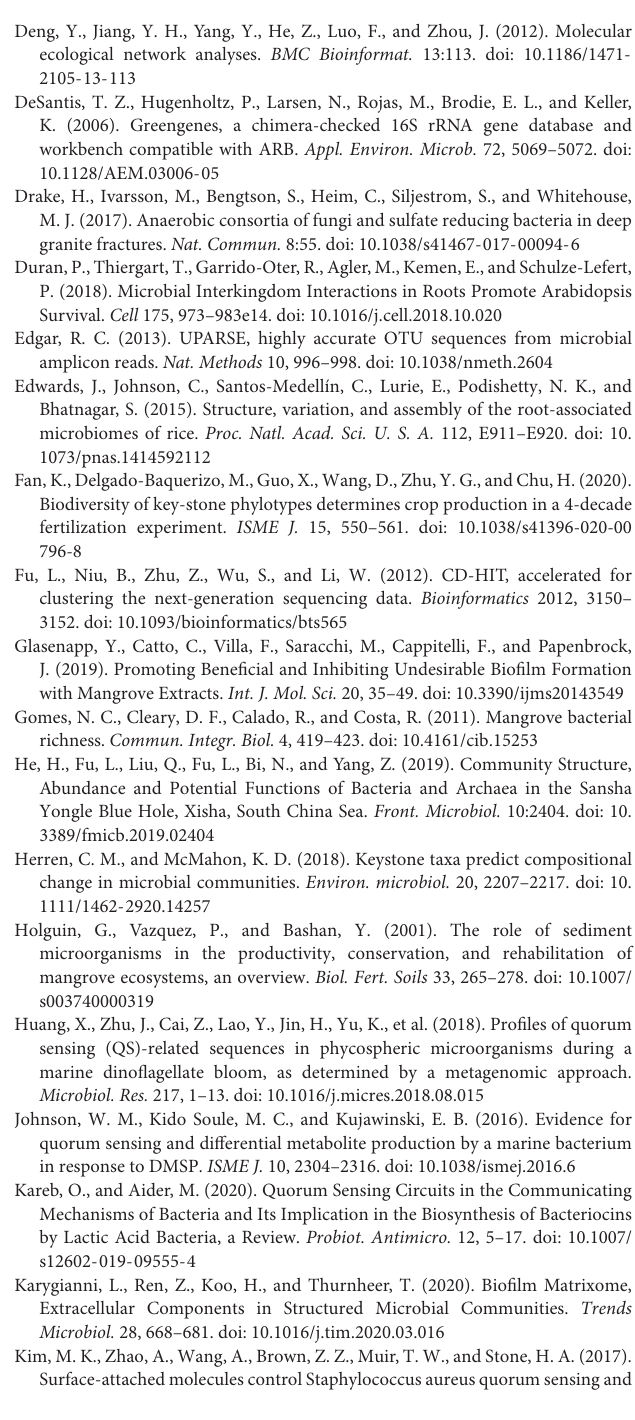
Supplementary Table 2 | KO (KEGG Orthology) numbers of quorum sensing and cobamide biosynthesis related genes. Supplementary Table 3 | Taxonomy information and relative abundance of keystone taxa in bacterial-fungal association (BFA), bacterial and fungal networks across the non-rhizosphere (Non), rhizosphere (Rhi), episphere (Epi), and endosphere (Endo) compartments.